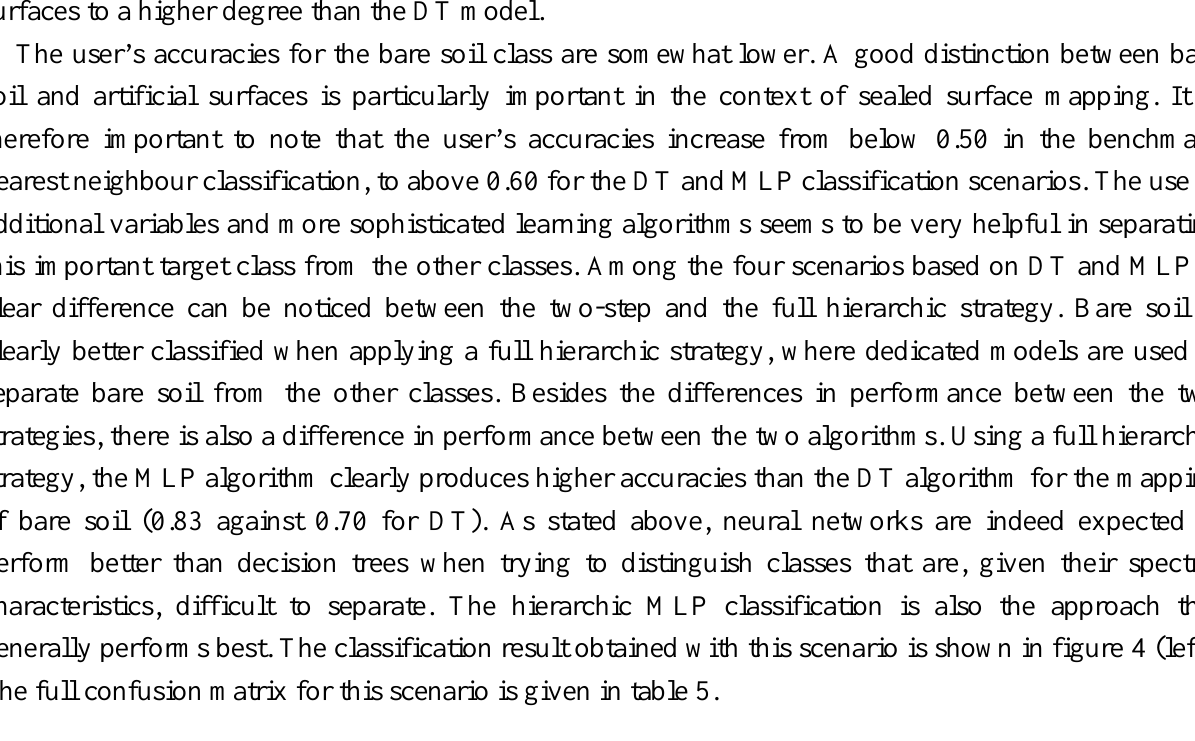
Table 5. Confusion matrix for the full hierarchic multi-layer perceptron classification result before shadow